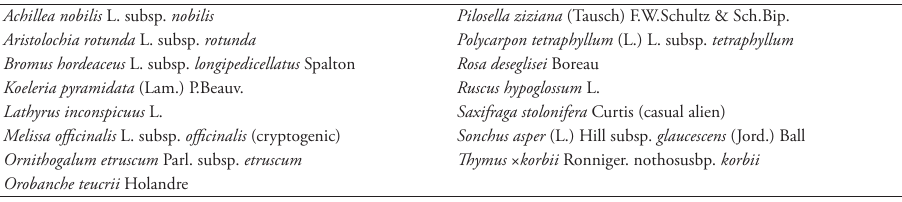
Table 3. List of taxa new for Basilicata. Achillea nobilis L. subsp. nobilis